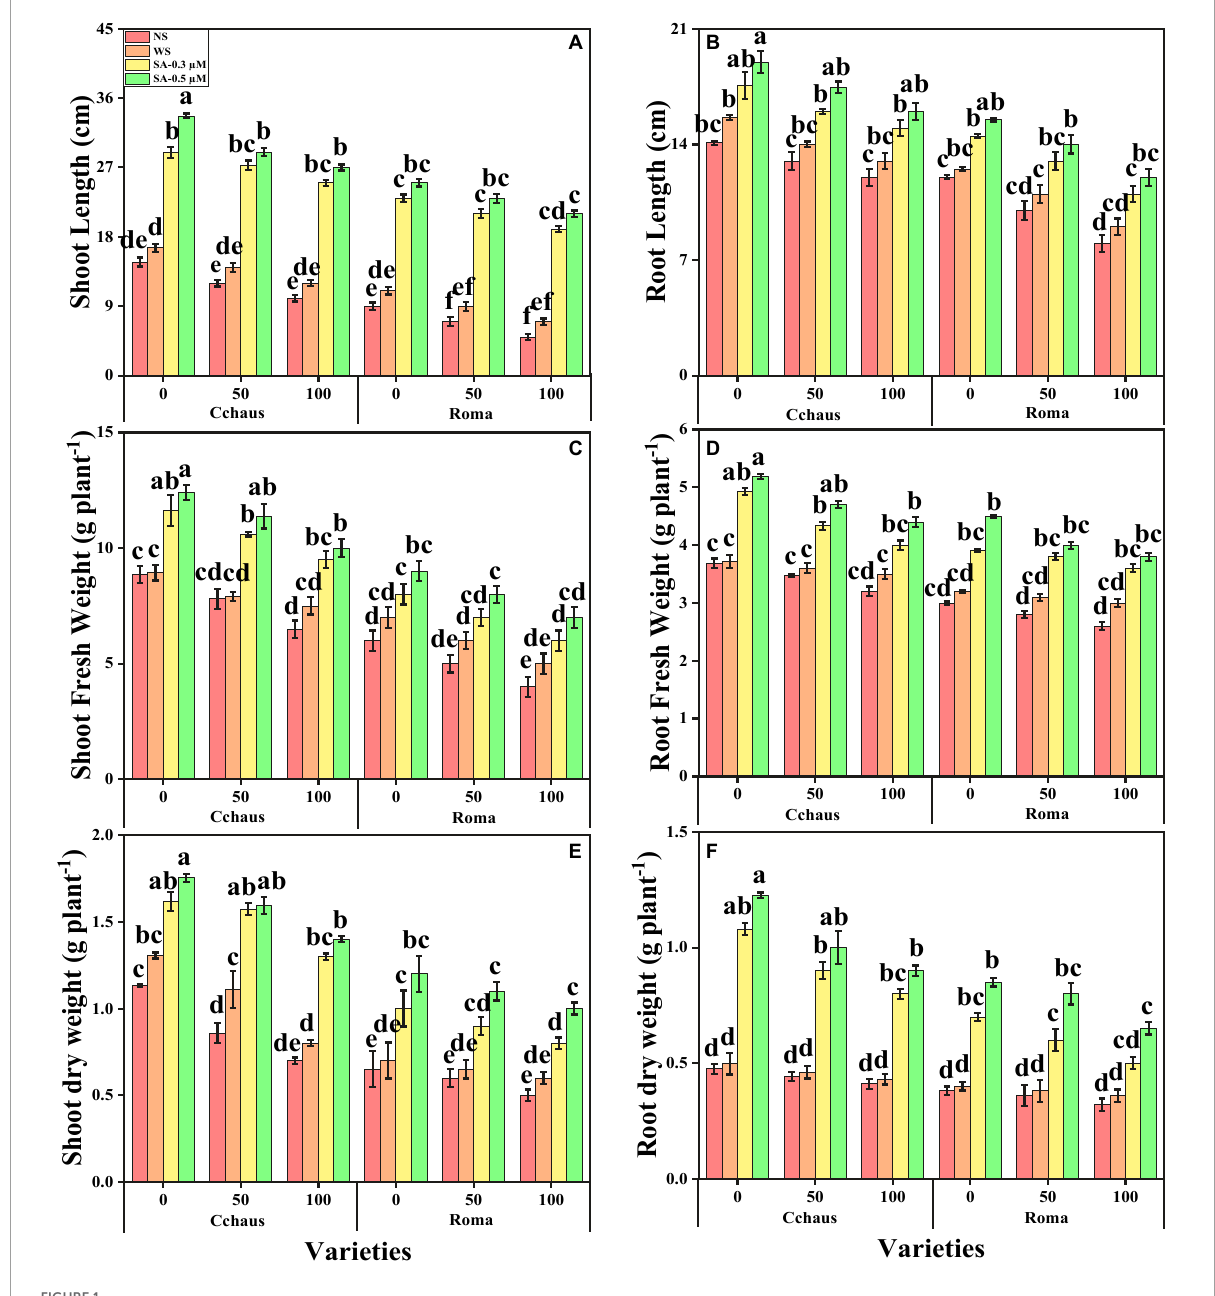
FIGURE1 Effect of exogenously applied syringic acid (0.3-0.5 ◦ µ M) on shoot length (A) , root length (B) , shoot fresh weight (C) , root fresh weight (D) , shoot dry weight (E) , and root dry weight (F) on Solanum lycopersicum varieties (Cchaus and Roma) cultivated under stress levels of Pb [0 (no Pb), 50 and 100 mg kg − 1 ]. Values are demonstrated as means of four replicates along with standard deviation (SD; n = 4). Two-way ANOVA was performed and means differences were tested by HSD ( P < 0.05) through Tukey’s test. Different lowercase letters on the error bars indicate significant difference between the